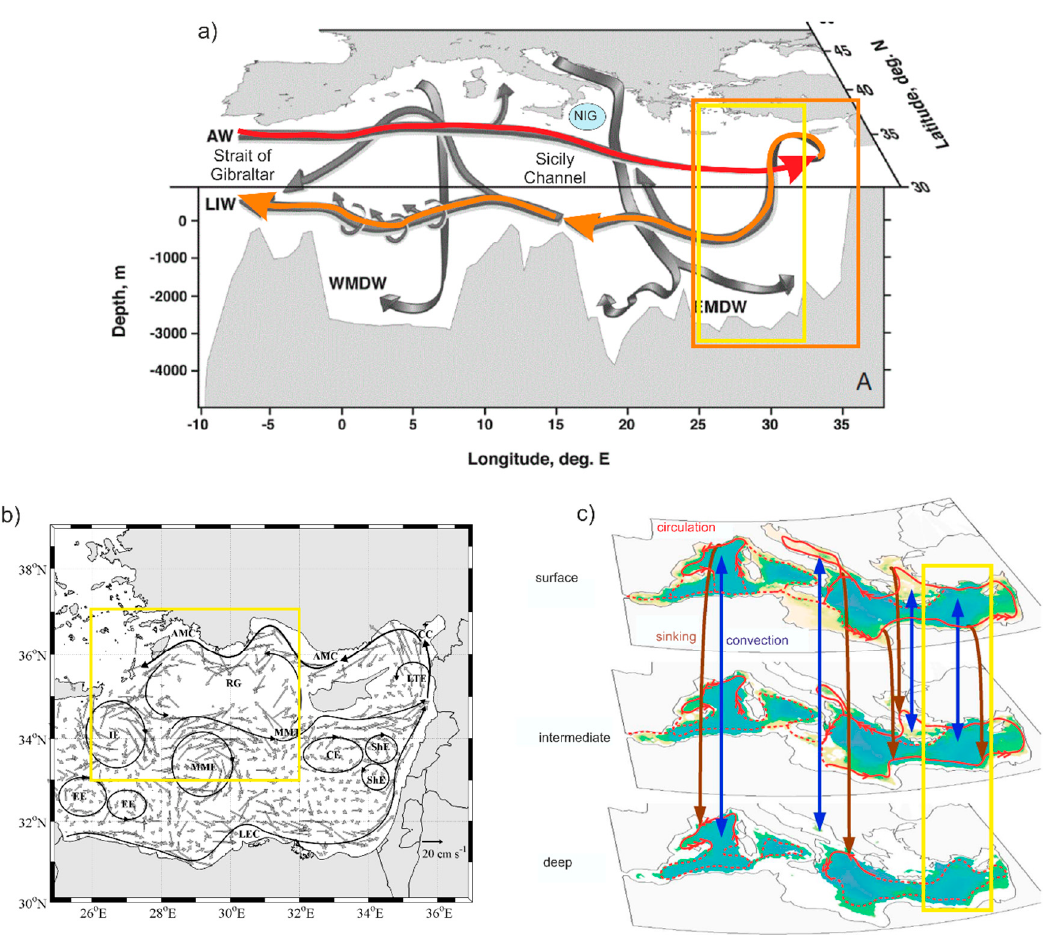
Figure 1. ( a ) General concept of the thermohaline circulation which, according to the prevailing view, is driven by a few convection sites within the Mediterranean Sea, adapted from [1]. The red arrow shows the entering Atlantic water (AW) while the orange arrow shows the Levantine intermediate water (LIW), which travels throughout the Mediterranean and flows into the Atlantic Ocean. The orange and yellow frames highlight the area of the Levantine Sea and of the Northwestern Levantine Sea (NWLS), respectively. The blue circle indicates the position of the North Ionian Gyre (NIG) the circulation of which is important for the advective salinity preconditioning. ( b ) Mean surface geostrophic circulation in the Levantine Sea from 1992 to 2010 derived from drifter data. The yellow rectangle indicates the area of study, the NWLS (latitude: 33–37°, longitude: 26–32°). Adapted from